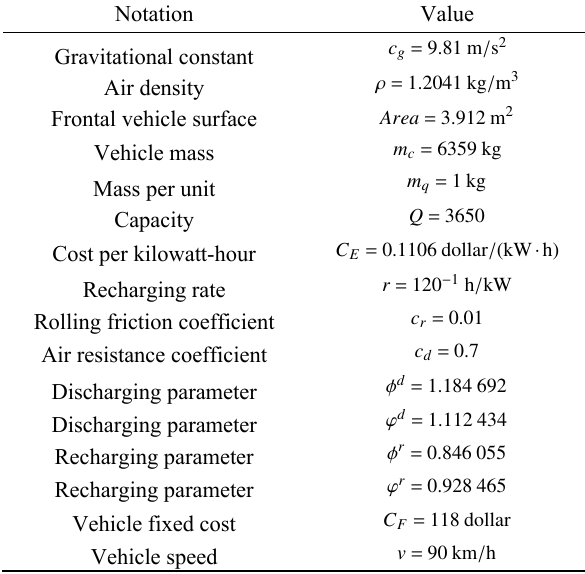
Table 1 Constants and parameters for instances.